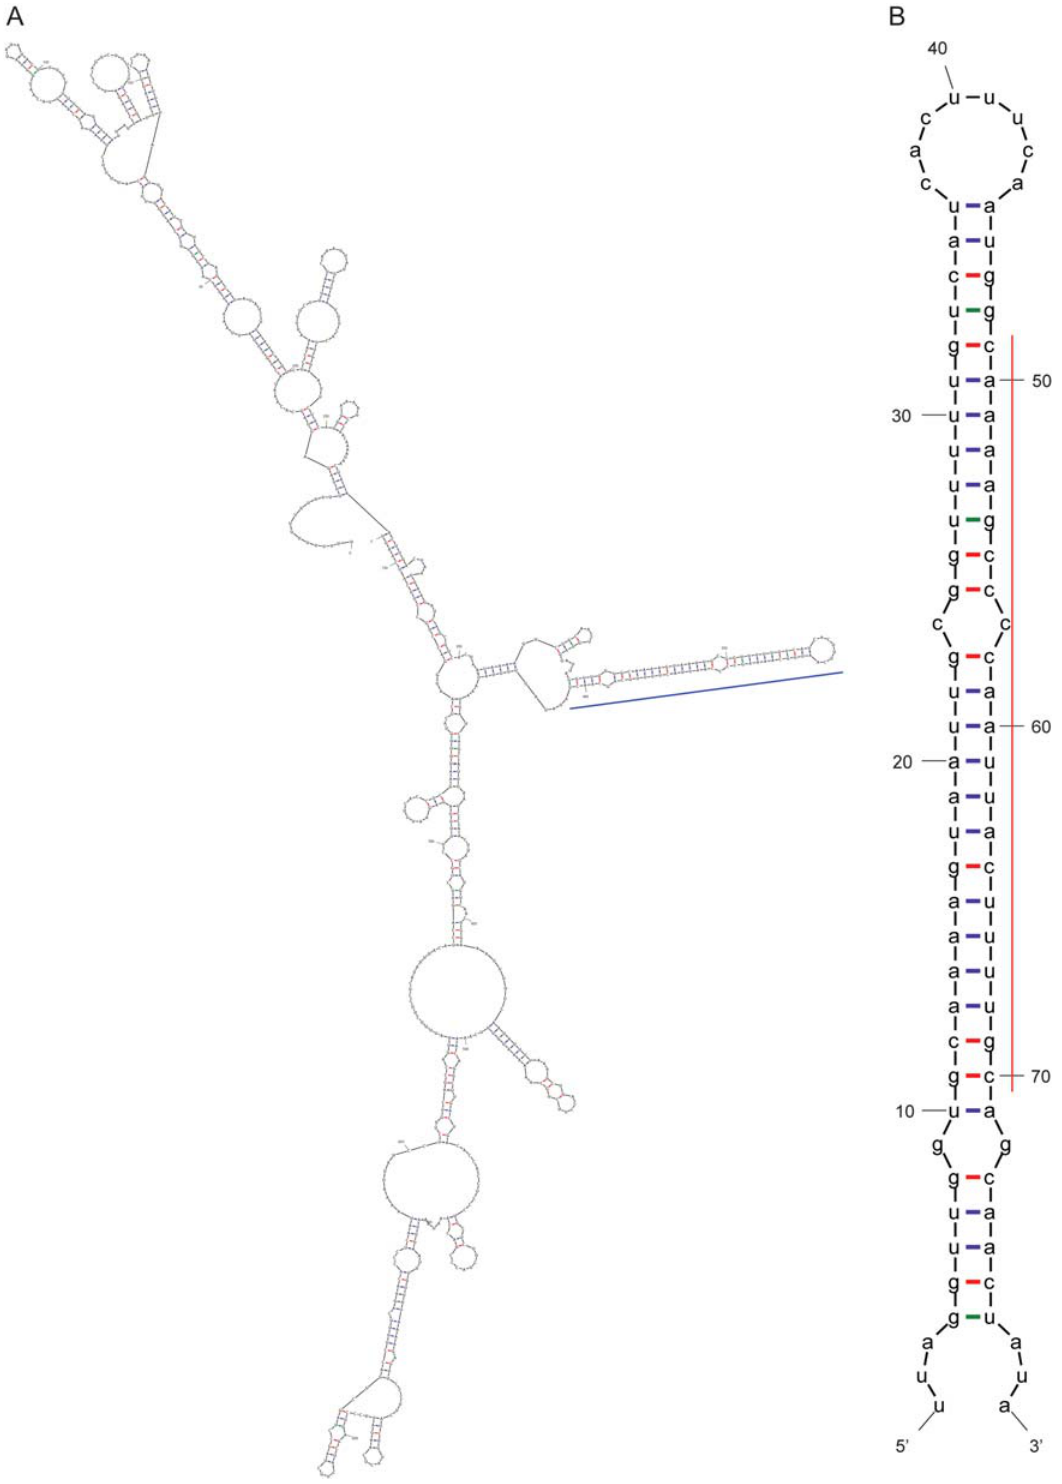
Figure 4. RNA secondary structures of the entire BU608159 EST (A) and the Made1 element contained within this transcript (B). The Made1 hairpin region of the BU608159 structure is indicated with a blue bar (A), and the location of the mature miRNA sequence is shown with the red bar (B).